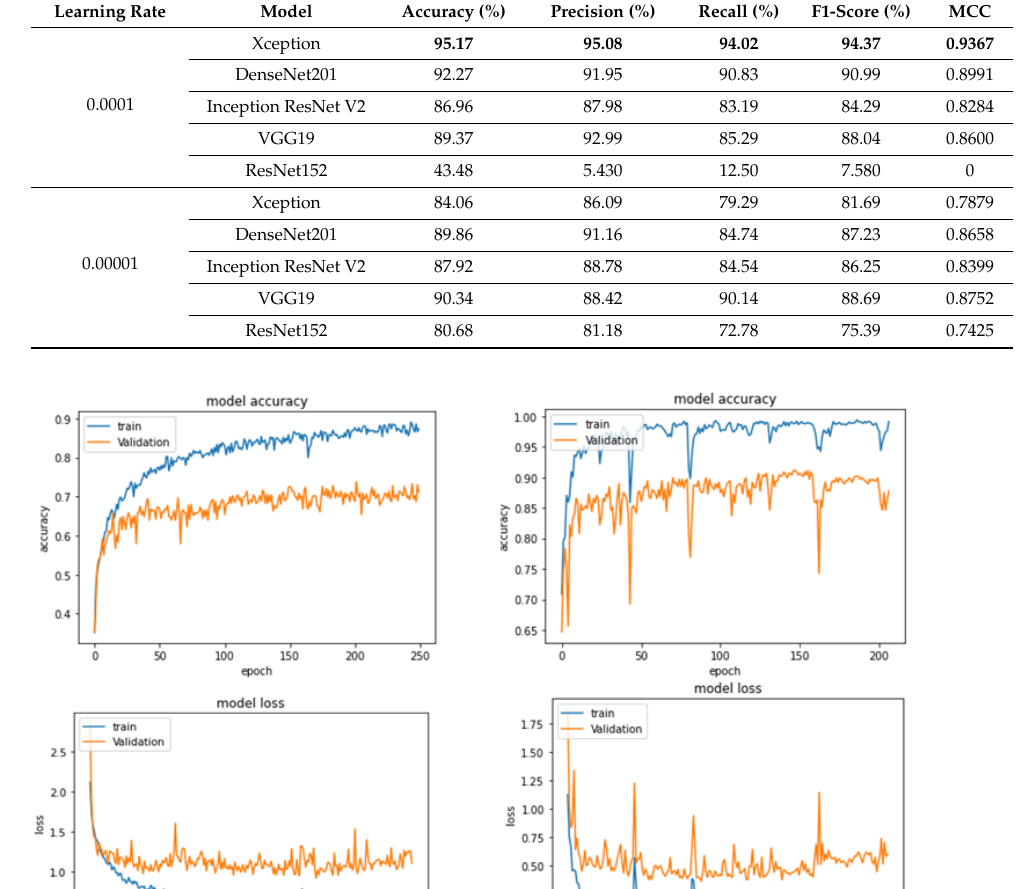
Table 11. Results of 100 × magnification factor in multi-classification mode; the highest results are shown in bold.